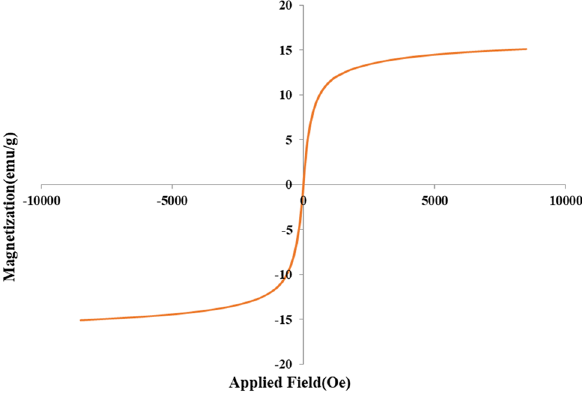
Figure 7. The VSM analysis of Fe 3 O 4 @Void@m.SiO 2 .